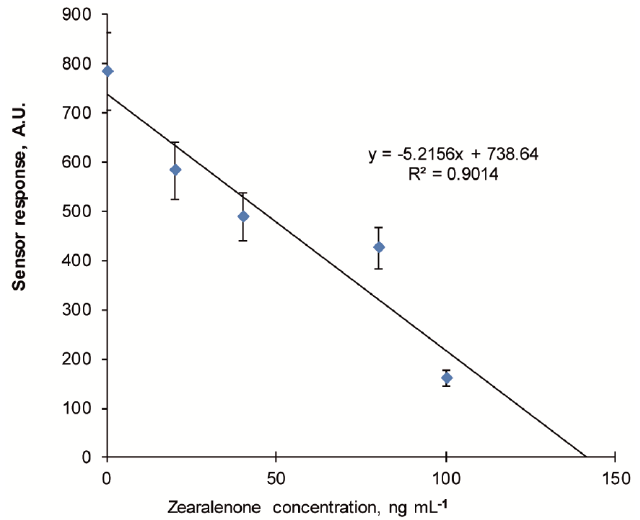
Figure 9. Typical calibration plot of the fluorescent sensor for zearalenone detection in competitive mode using 2-[(pyrene-l-carbonyl)amino]ethyl 2,4-dihydroxybenzoate (PARA) as a fluorescent tracer. Fluorescence of the MIP membranes after incubation in 40 ng mL − 1 PARA solution containing 10–200 ng mL − 1 zearalenone and 10% acetonitrile (working solution for the measurements is 20 mM Na-phosphate buffer, pH 6.0, containing 150 mM NaCl).